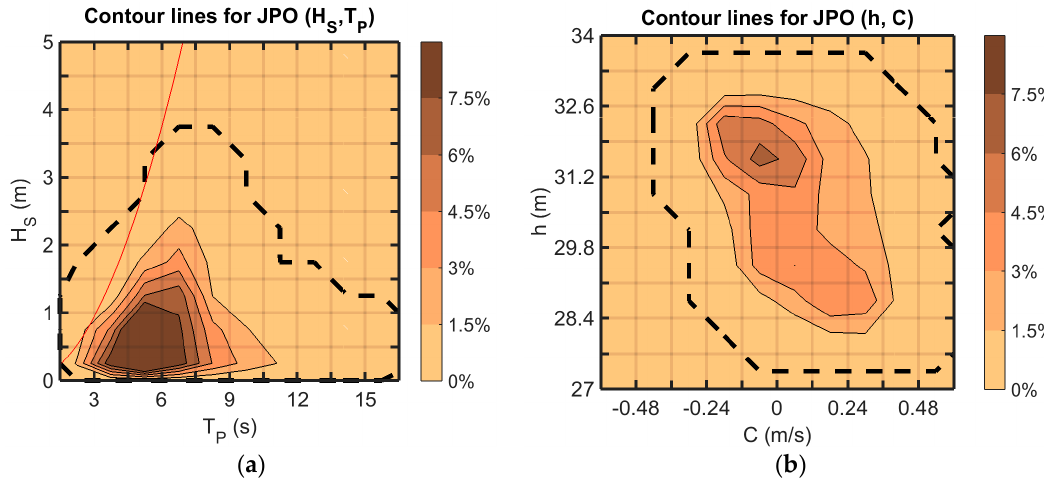
Figure 8. JPO for SWMTF general ( a ) wave measurements ( H S , T P ) and ( b ) current measurements ( h , C ).